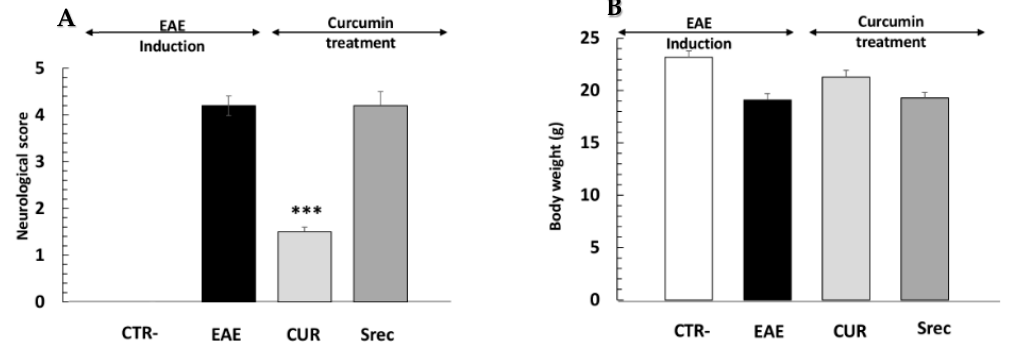
Figure 3. Effect of curcumin on the neurological signs of EAE. ( A ) Neurological scores were recorded daily, then analyzed, plotted and compared between groups. ( B ) Body weight of animals in experimental groups during the study. Negative group (CTR-), encephalomyelitis autoimmune experimental (EAE) group, post-treated with curcumin (CUR) group, spontaneous recovery (Srec) group. Values are given as mean ± SEM as the results of ordinary one-way ANOVA followed by Tukey’s multiple comparison test. *** p < 0.001.